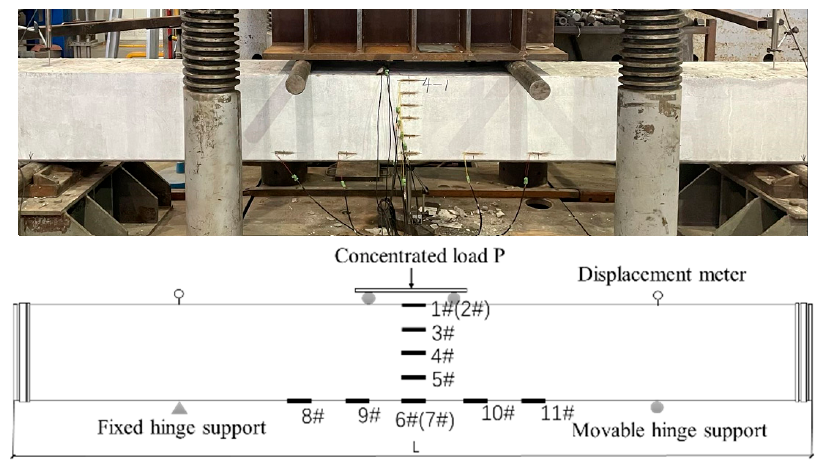
Figure 4. Specimen loaded by bending.